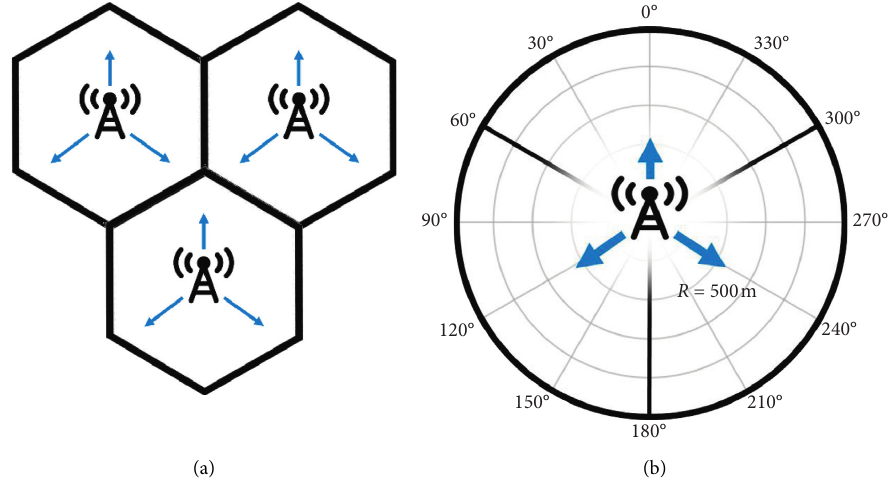
Figure 2: (a) Voronoi centered on BTS. (b) Trisector BTS with 3